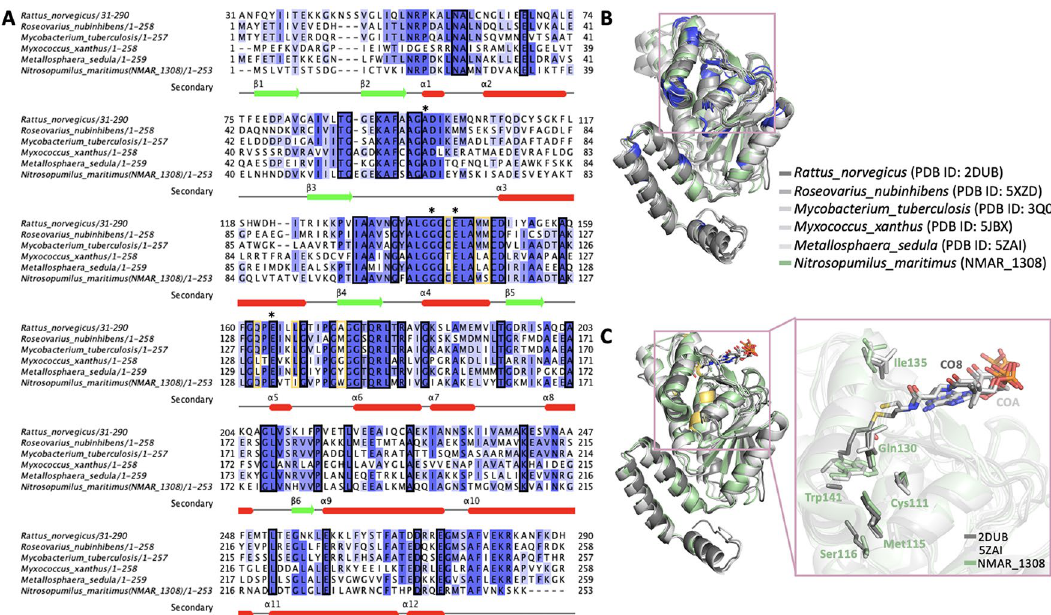
Figure 5. Overall representation of sequence alignment results. ( A ) Homologous hydratases ( Rattus norvegicus (2DUB), Roseovarius nubinhibens (5XZD), Mycobacterium tuberculosis H37Rv (3Q0J)) and dehydratase ( Myxococcus xanthus (5JBX)), bifunctional ( Metallosphaera sedula (5ZAI)) sequences are aligned to show conserved and critical residues for functioning of Nmar_1308. Black squares represent the conserved residues in the sequence alignment while yellow orange color is used to indicate the observed critical residues. The catalytic residues during hydratase/dehydratase reaction is indicated with asterisks on the top of the sequence. ( B ) Slate color indicates conserved regions on the structure based on the sequence alignment result in panel A. The detected conserved residues in the hydrophobic binding pocket are shown with a pink square. ( C ) Residues implicated in the catalysis, Cys111, Met115, Ser116, Gln130, Ile135, and a residue important for limiting substrate size, Trp141, around the hydrophobic binding pocket are shown on the superposed structures of Nmar_1308, Rattus norvegicus hydratase (PDB ID: 2DUB) and bifunctional dehydrate/hydratase from Metallosphaera sedula (PDB ID: 5ZAI). Panel A is generated by Jalview software. Panel B and C are generated by PyMOL (www. schro dinger. com/